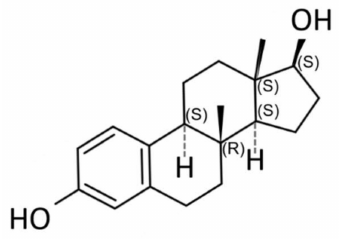
Figure 8. Chemical structure of 17 β